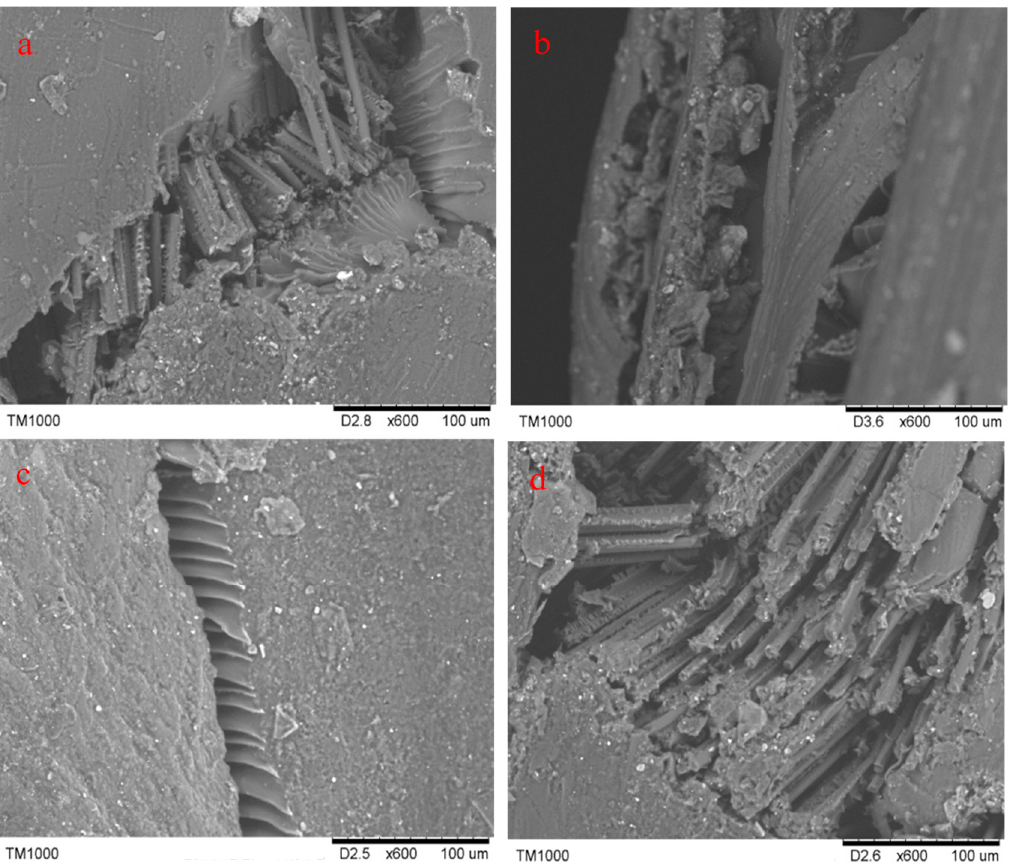
Figure 8. Electron micrograph of lateral crack after bending fracture in 3Dim–5Dir braided composites at 90 °C with different durations ( a ) at room temperature; ( b ) 90 °C 0.25 h; ( c ) 90 °C 10 h; ( d ) 90 °C 30 h.